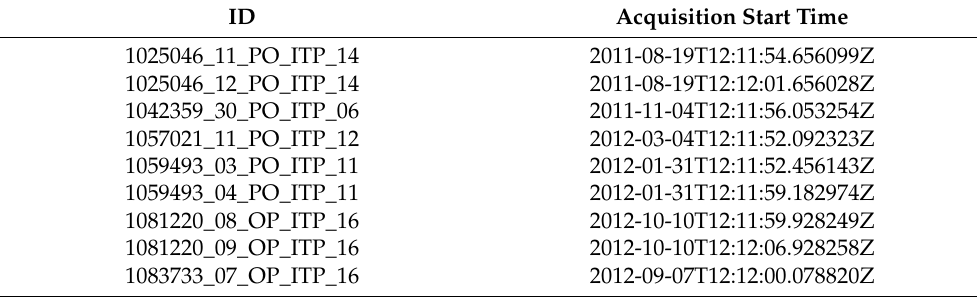
Figure A1. Monthly average temperature and precipitation on ZK from the European Center for Medium-Range Weather Forecasts Re-Analysis Interim (ERA-Interim), 1979–2015. Table A1. Information on raw tiles in TDM90 covering the ZK glaciers.